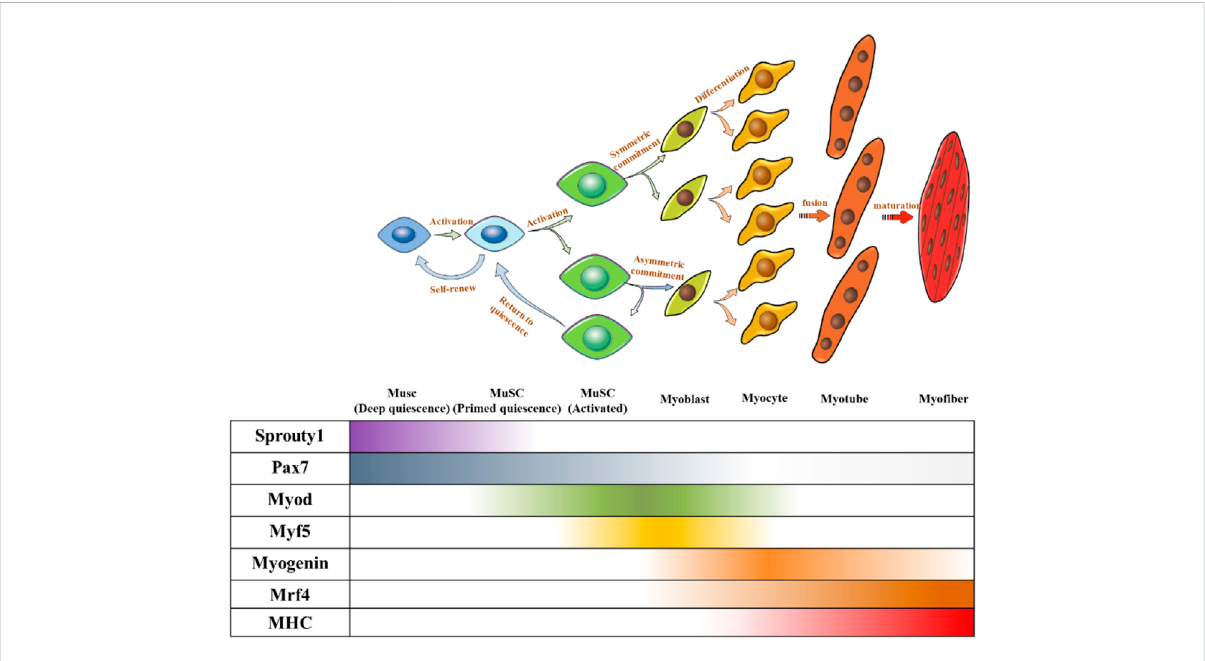
FIGURE 2 Fate regulations of MuSC towards muscle differentiation and self-renewal. Quiescent MUSC express Pax7, and symmetric division upon MuSC activation can produce two identical MuSCs to maintain a stable MuSC pool, and asymmetric division can produce one MuSC, one myogenic committed cell. Myogenic committed cells express MRFs step-by-step to differentiate into myocytes. Myocytes stop proliferating and fuse to form multinucleated myotubes. Myotubes further mature and bundle together to form myo fi